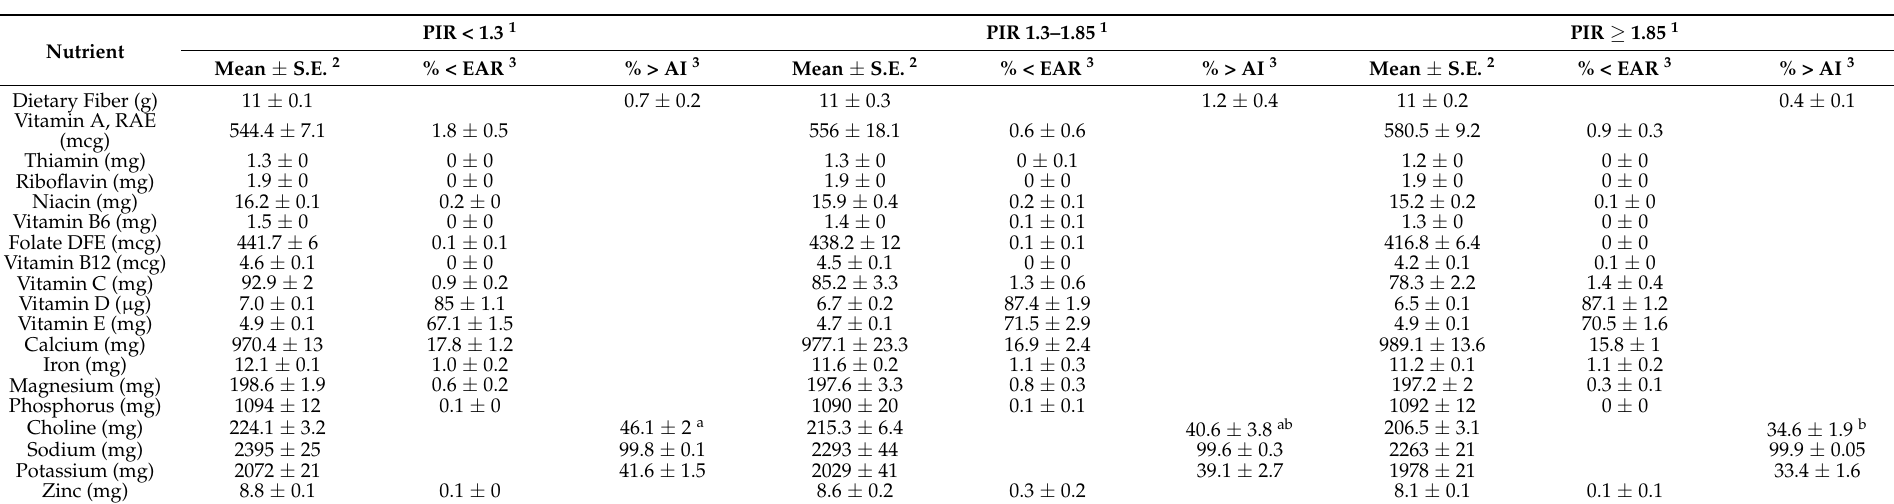
Table 4. Mean nutrient intake of children 1–6 years and proportion not meeting DRIs by Poverty Income Ratio (NHANES